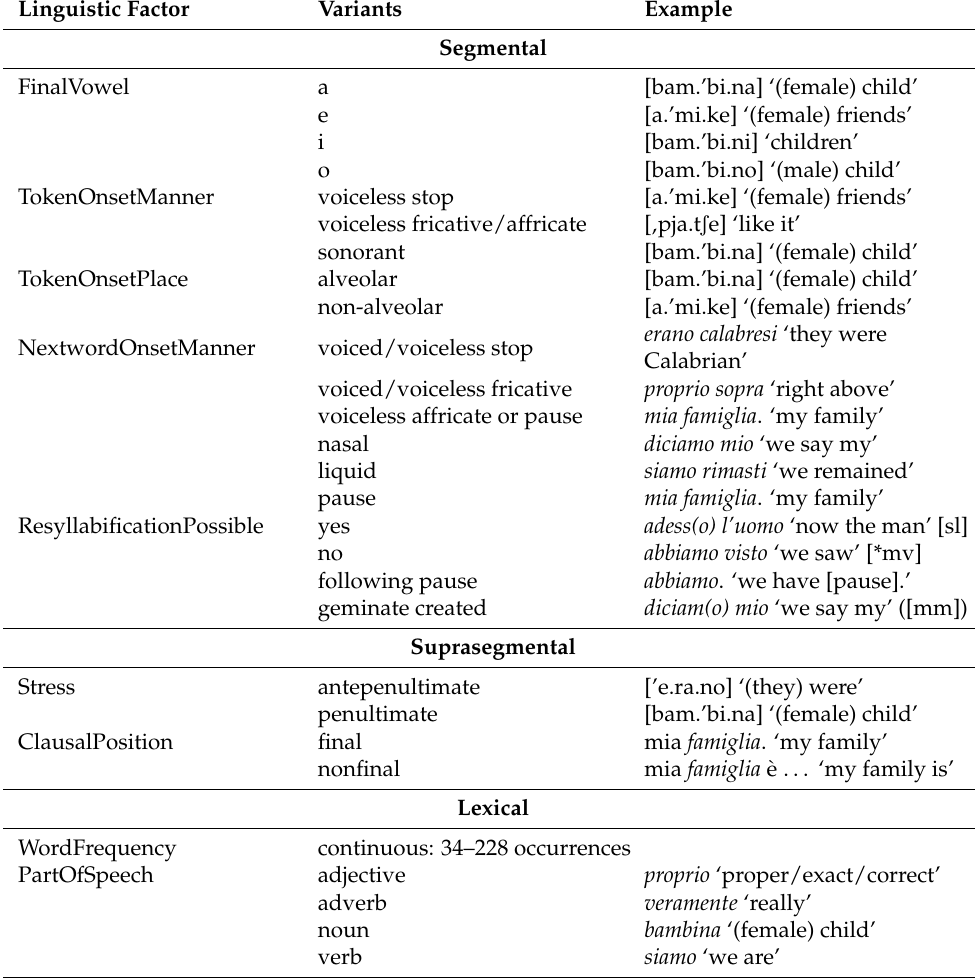
Table 2. Linguistic factors analyzed and their